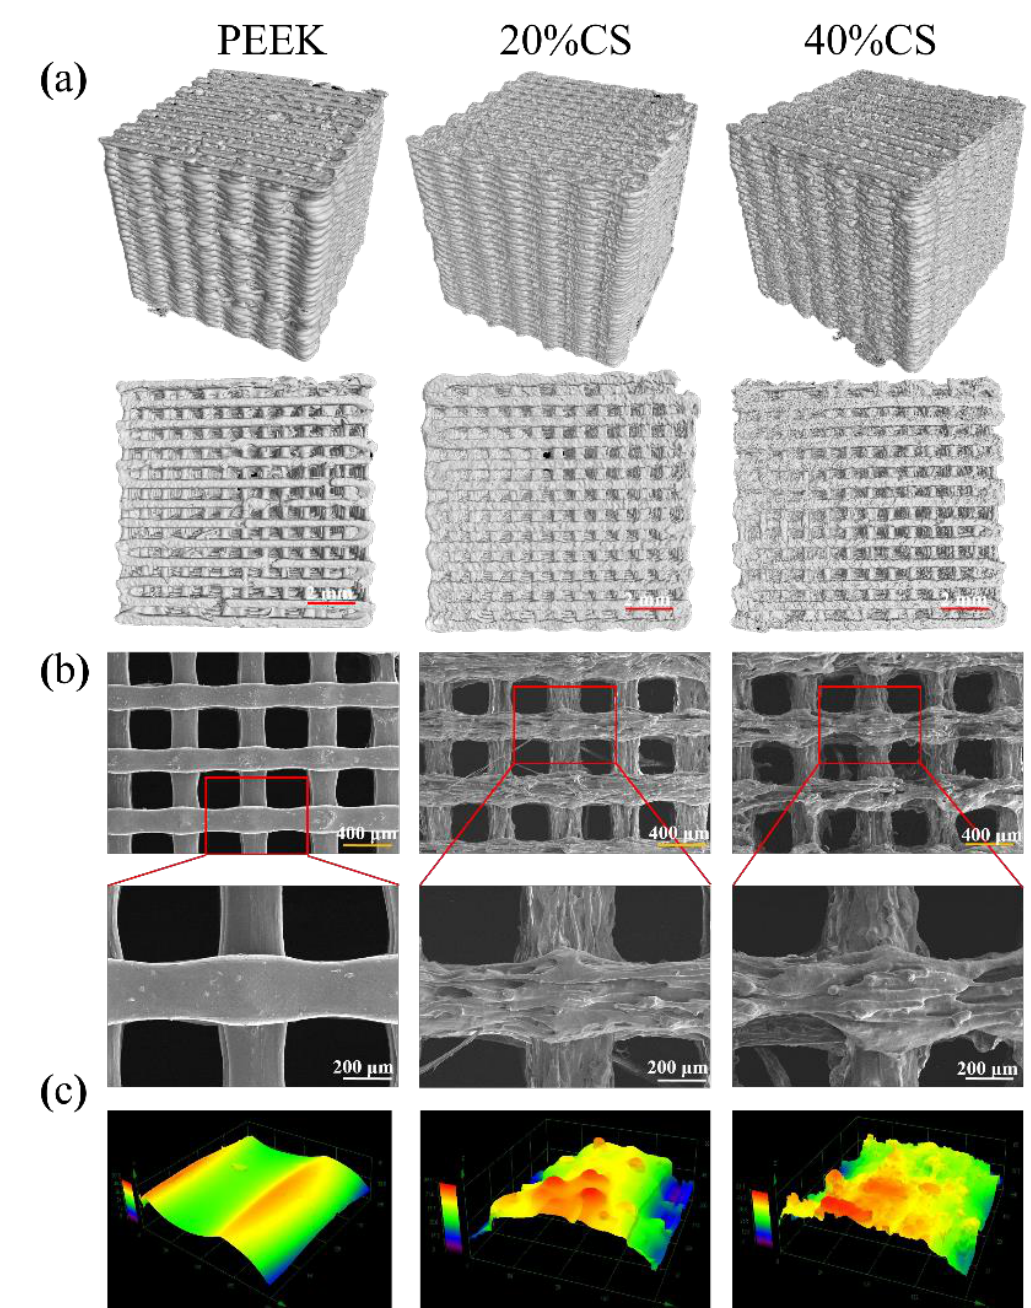
Figure 2. Micro-structure characteristics of the PEEK/CS scaffold samples: ( a ) geometry observation by micro-CT, ( b ) surface morphology by SEM and ( c ) three-dimensional topography by LSCM. Table 1. The porosity of three scaffolds with different raster angle.